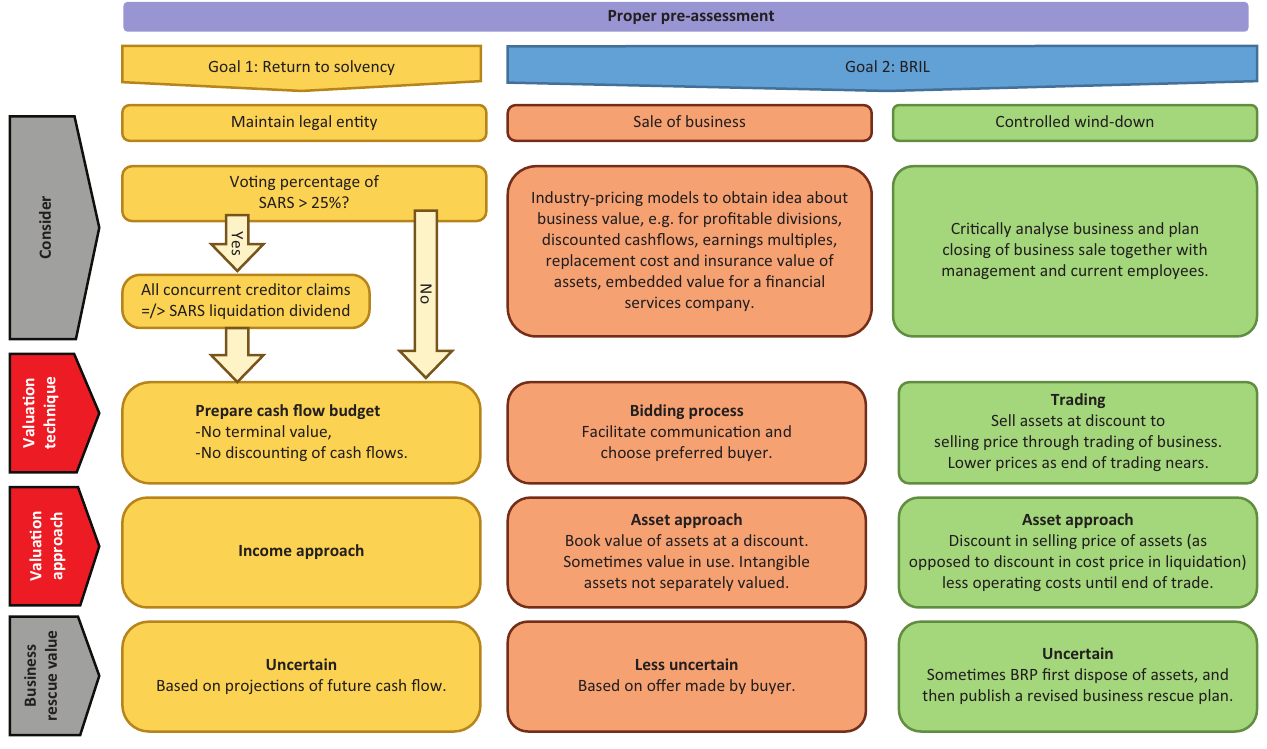
FIGURE 3: Valuation approaches and other valuation considerations.